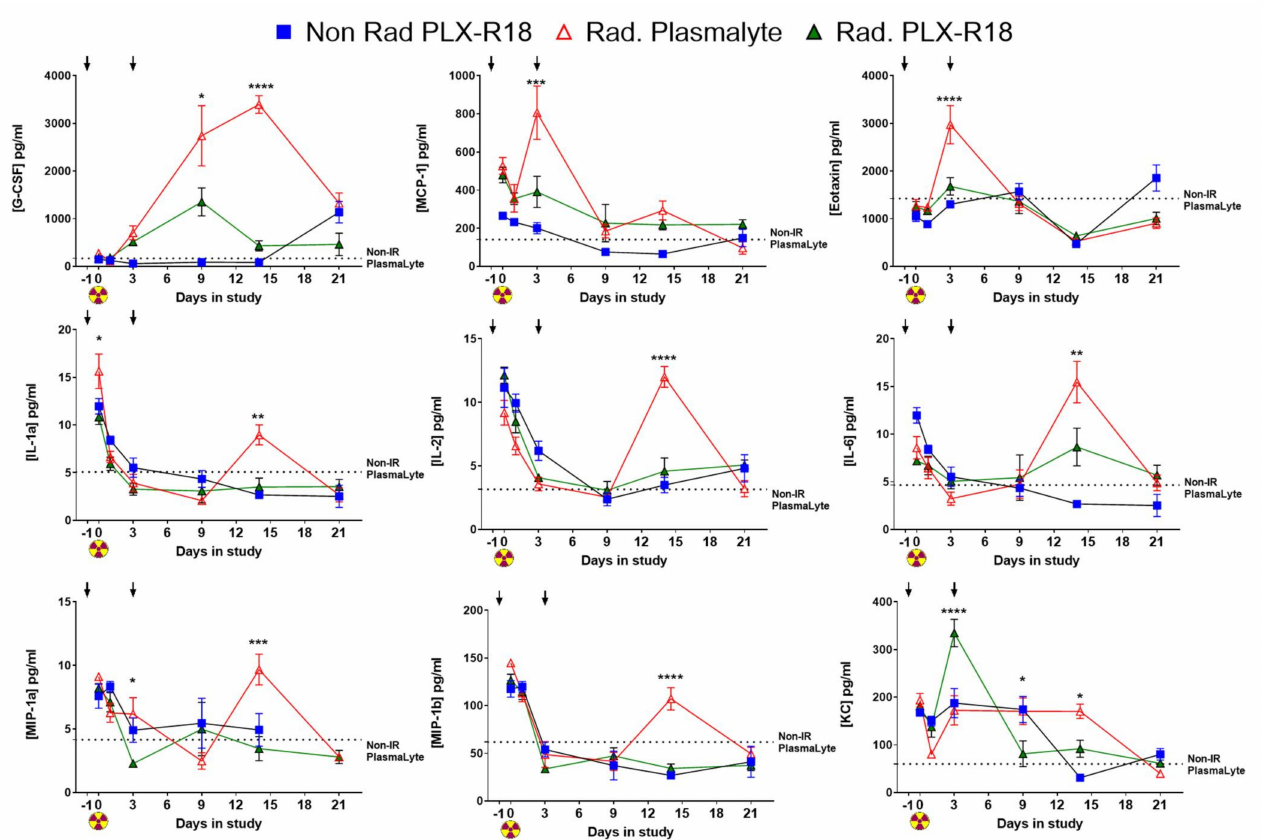
Figure 6. Differential levels of circulatory cytokines & recovery by PLX-R18 by Luminex assay. Serum samples were subjected to an array of 23 cytokines. The four murine proteins were significantly elevated (n = 5/time point). * p < 0.05, ** p < 0.01, ***/**** p < 0.0001. That yellow symbol means the day of radiation. The arrow means the days we administered the